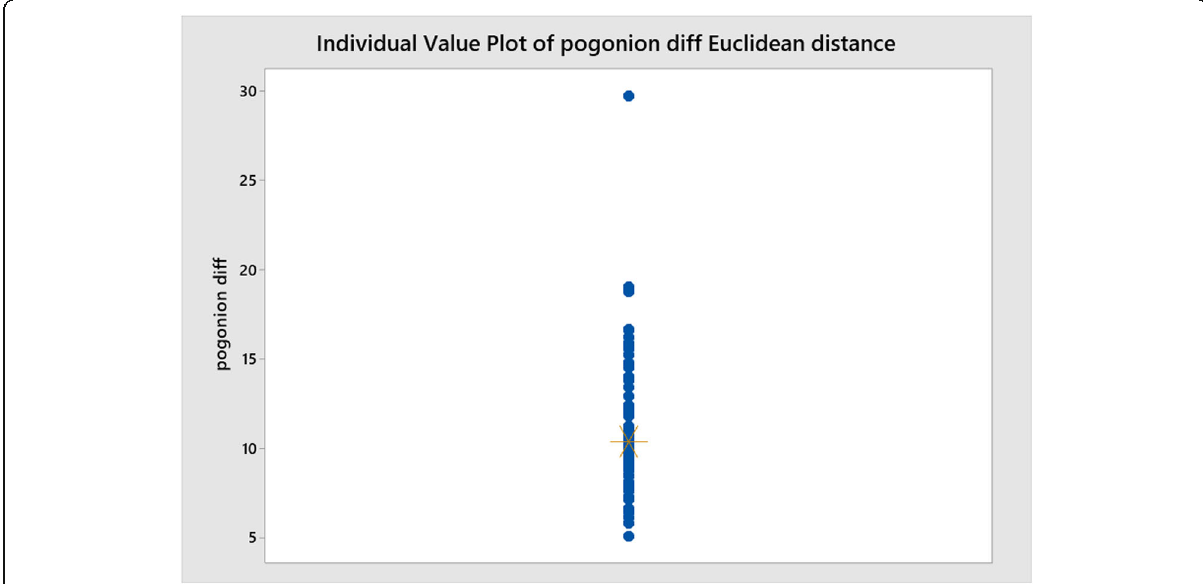
Fig. 7 Individual value plot showing mean distances between traced position of Go and estimated position by Sassouni+